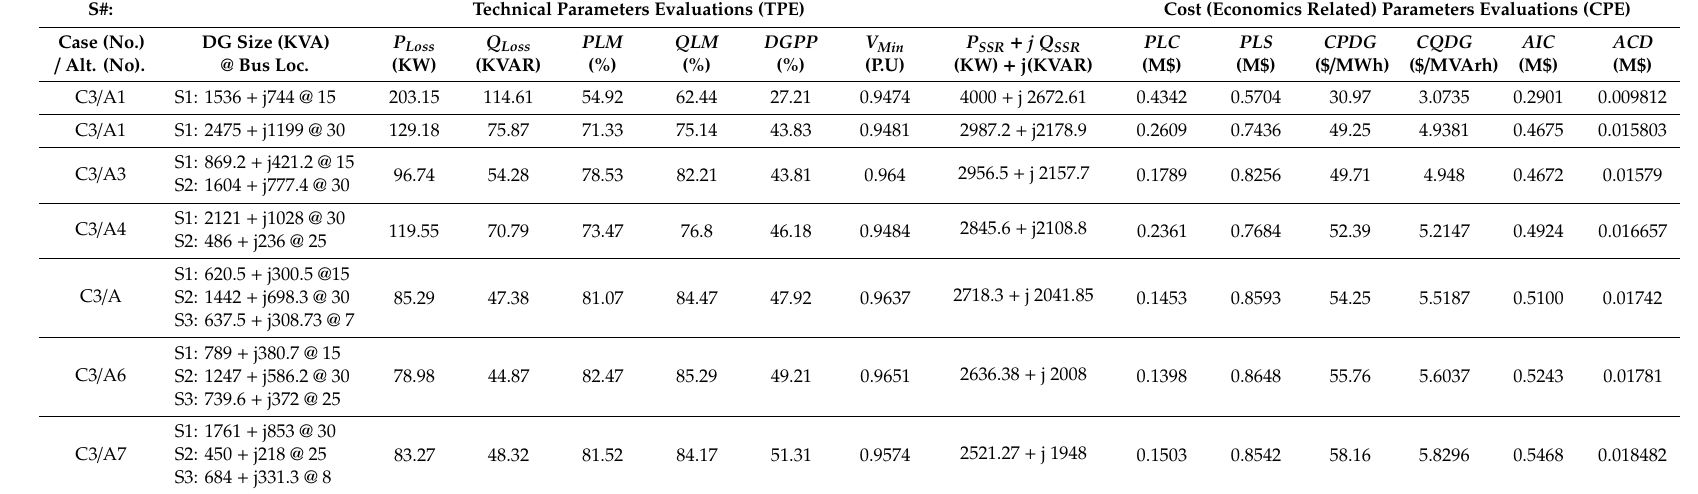
Table 17. Techno-economic evaluation analysis in case 3 (C3_LG) for 33-bus MDN.